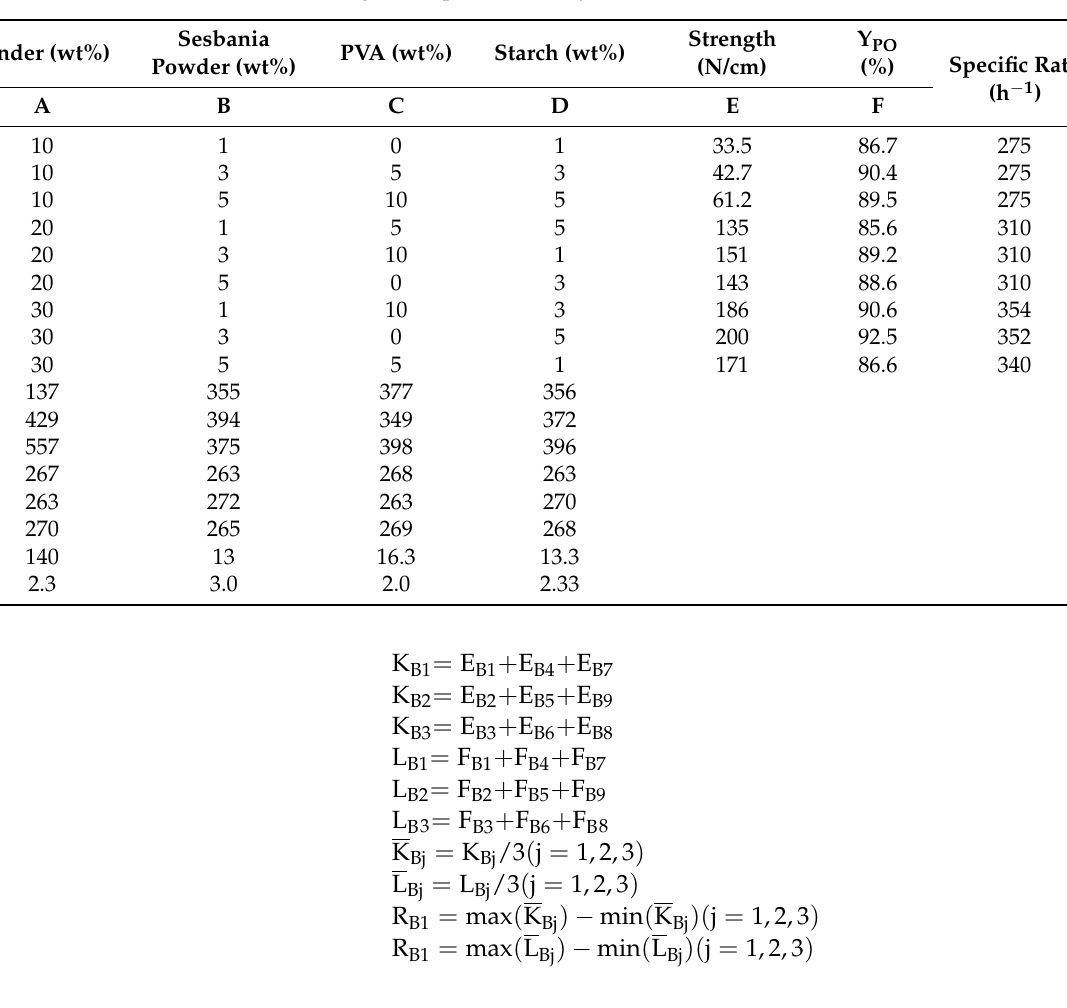
Table 3. Orthogonal experiment array L 9 (3 4